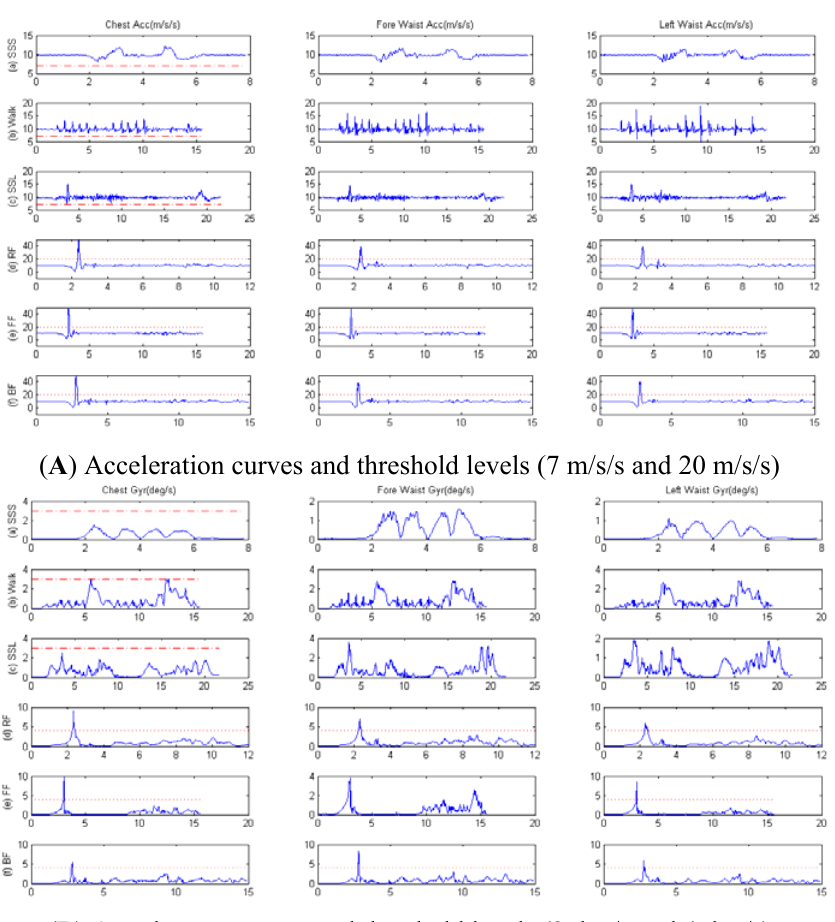
( B ) Angular rate curves and threshold levels (3 deg/s and 4